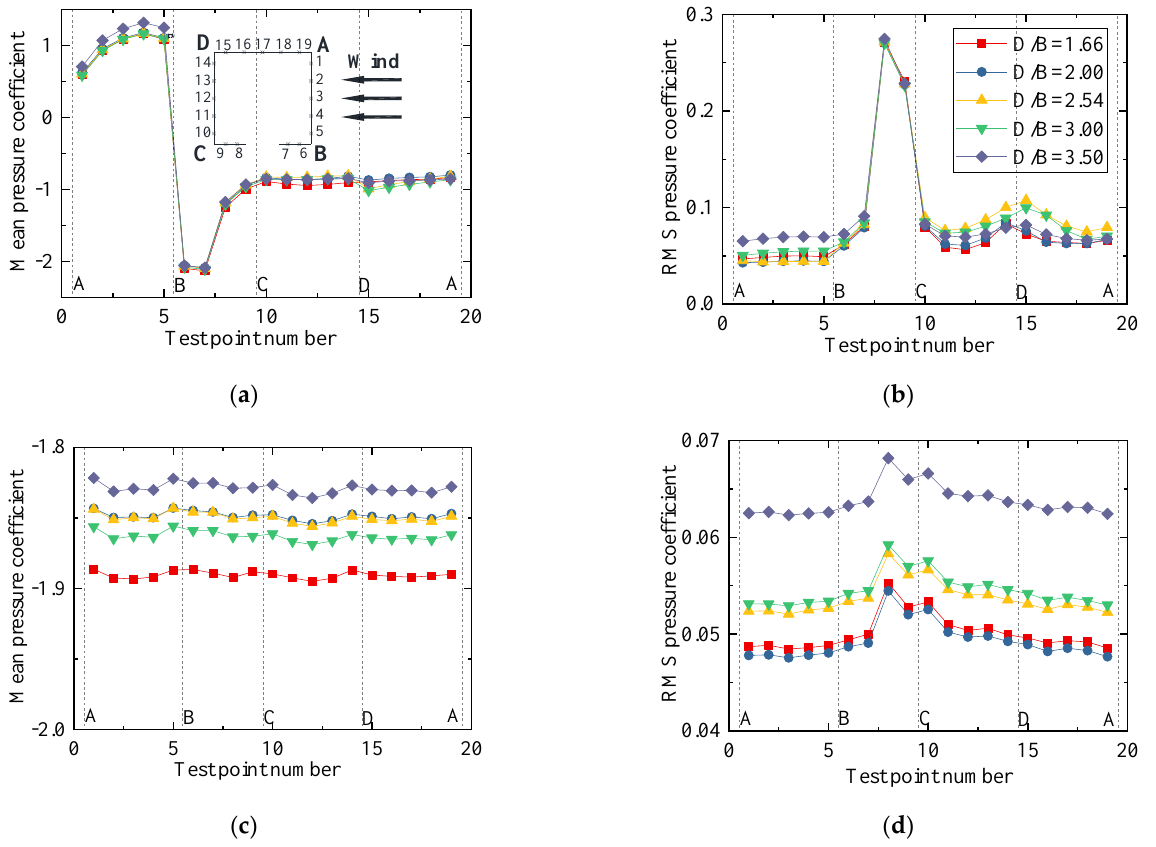
Figure 11. Wind pressure coefficients of the upstream bridge for Case 2: ( a ) Mean values for the outer taps; ( b ) RMS values for the outer taps; ( c ) Mean values for the inner taps; ( d ) RMS values for the inner taps.